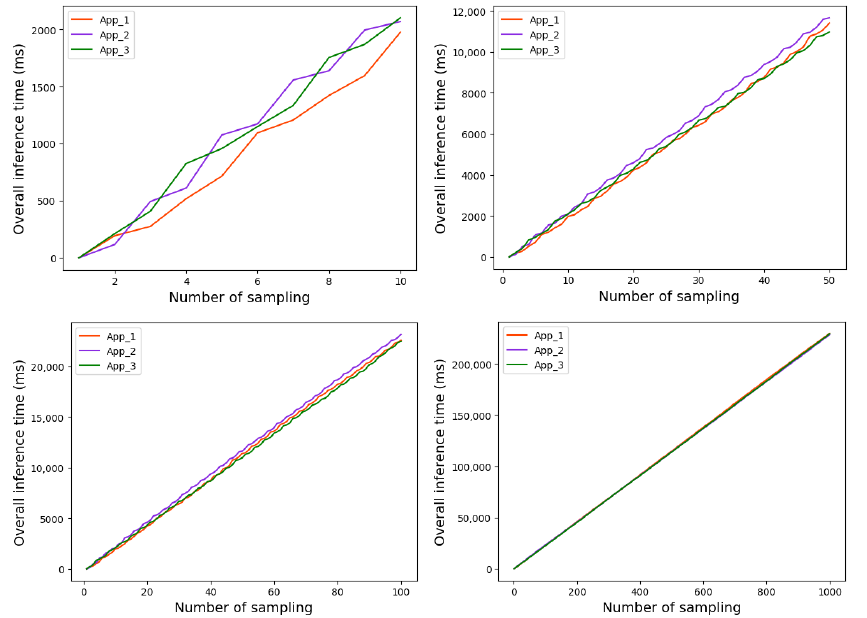
Figure 11. Overall running time of each App based on strategy